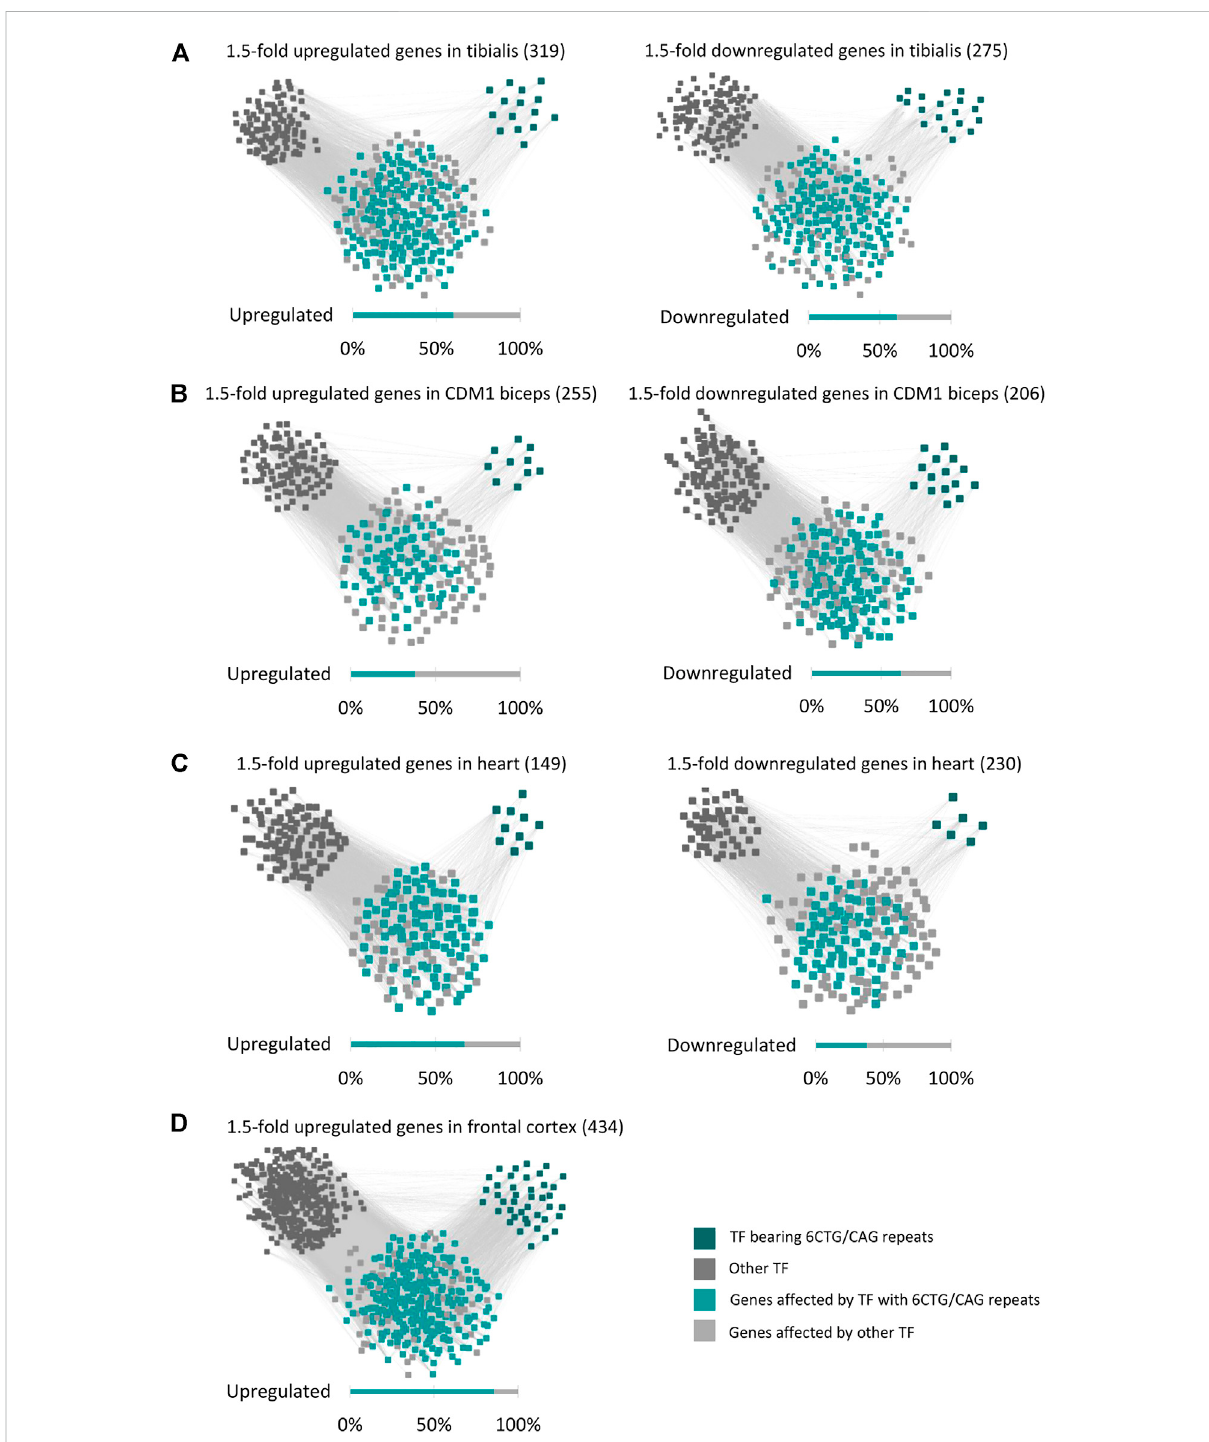
FIGURE 4 The regulatory network of the DM1 gene signature. Gene-transcription factor regulatory network of upregulated and downregulated genes in DM1 tibialis (A) , CDM1 biceps (B), DM1 heart (C), and DM1 frontal cortex (D) . Dark green squares represent transcription factors bearing 6CTG/CAG repeats and dark gray squares represent the remaining transcription factors. Cyan nodes stand for genes targeted by transcription factors bearing 6CTG/CAG repeats, light gray nodes stand for the remaining